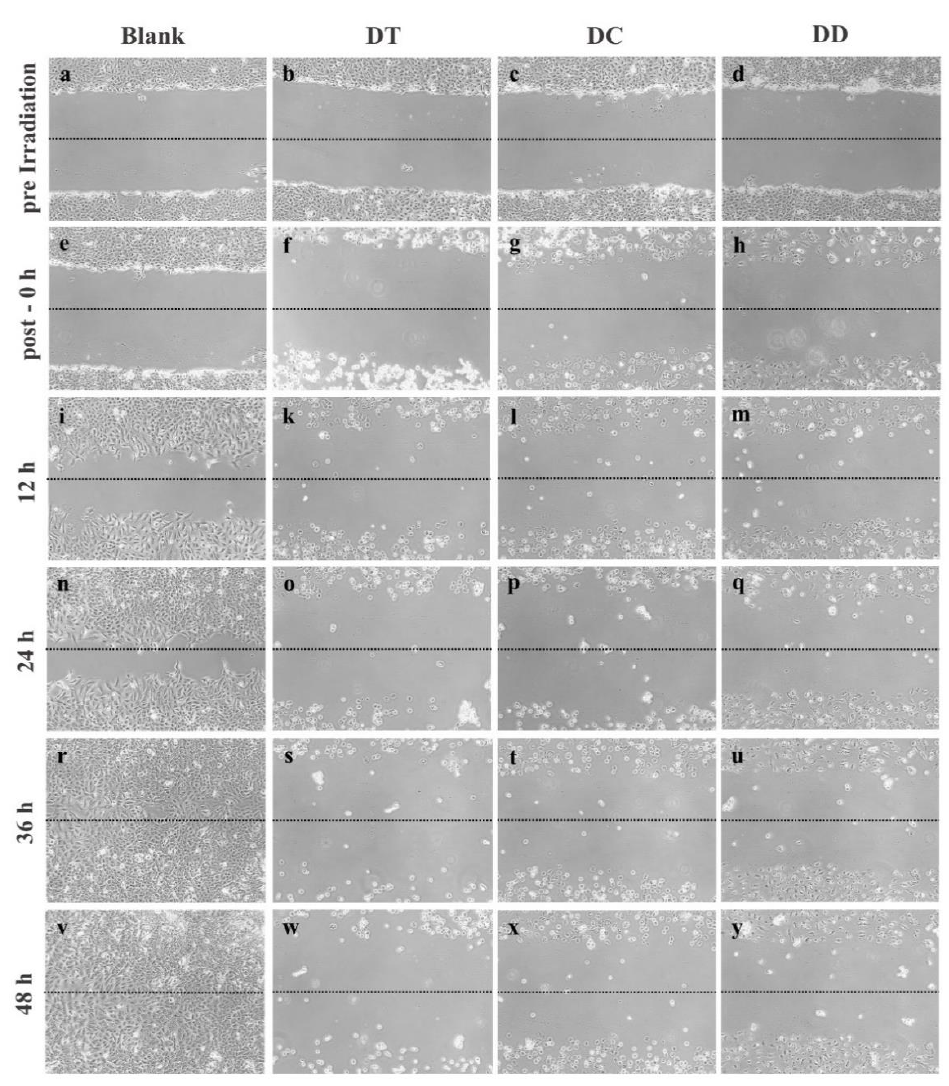
Figure 8. Microscopic images of the A549 cells during 48 h of the “in vitro scratch assay”. The images a, e, i, n, r and v show the natural migration of untreated cells (blank) compared to cell migration after PDT treatment with nebulised curcumin liposomes (b,e,d,f,g,h,k,l,m,o,p,q,s,t,u,w,x,y).